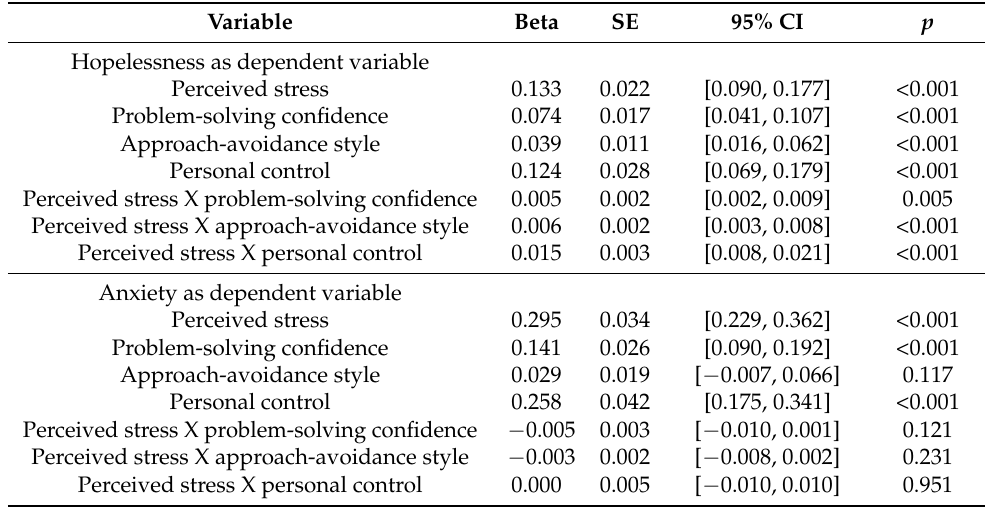
Table 3. Moderation analysis of the role of problem-solving appraisal in the relationship between perceived stress and psychological